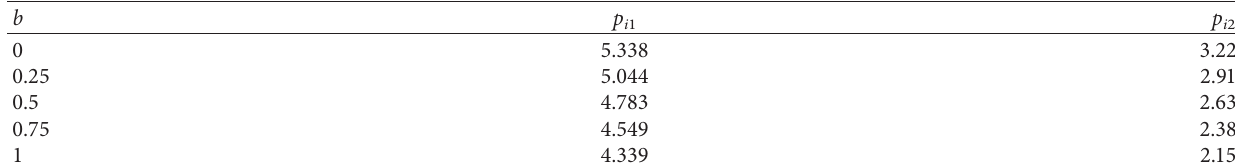
Table 1: Critical support pressure under different intermediate principal stress coefficients.